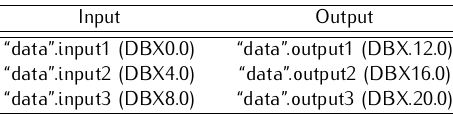
Table 2. Example setup of 3 addresses defined as inputs and 3 as